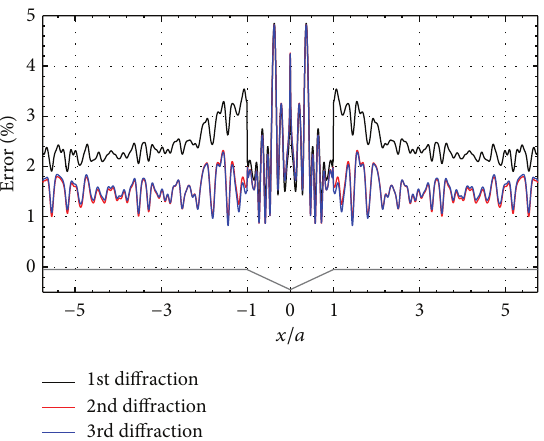
Figure 11: Error in the total field obtained in the frequency domain with 1, 2, and 3 orders of diffraction.